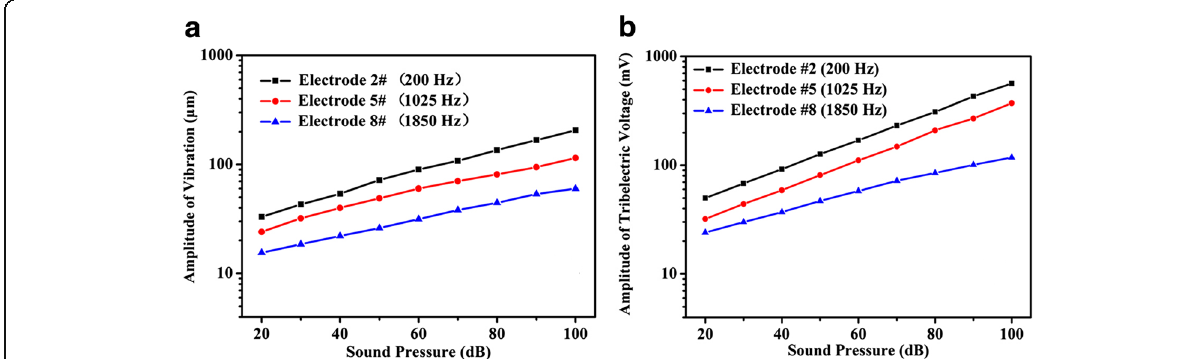
Fig. 3 Experimental results in effect of the acoustic pressure on amplitudes a of the vibration and b of triboelectric voltage output. Apparently, it is a kind of linear relationship between amplitude and sound